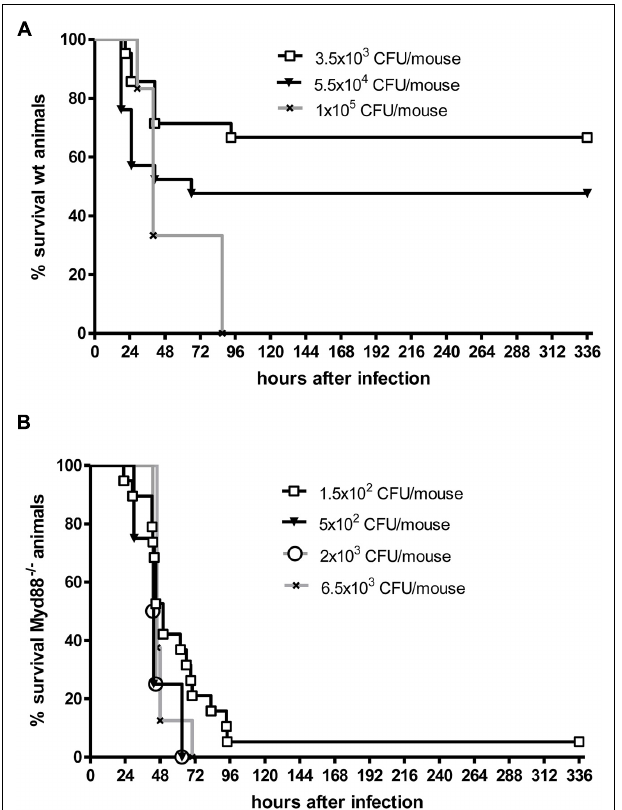
FIGURE 3 | Kaplan–Meier survival curves from (A) C57Bl/6J wild-type (wt) mice and (B) C57Bl/6J MyD88 − / − mice following intracerebral injection of different numbers of Escherichia coli K1 (kindly provided by Dr. Gregor Zysk, Düsseldorf). Meningitis was induced by bacterial inoculation into the right frontal neocortex under anesthesia. Please note that 70% of immunocompetent mice survived an intracerebral injection of 3500 colony-forming units (CFU). Conversely, over 90% of MyD88 − / − mice were killed by an intracerebral inoculum of 150 CFU in less than 4 days suggesting that MyD88 as a central signaling molecule of the innate immune system is essential for the inactivation of bacteria by parenchymal microglia and macrophages (Sandra Ribes, unpublished